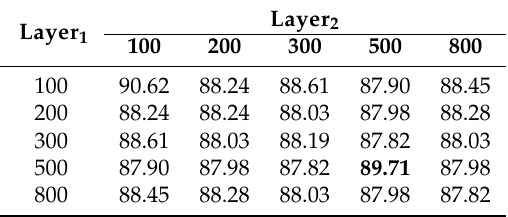
Table 6. Average classification accuracy results for an RBM with two hidden layers using the AAhydro set.